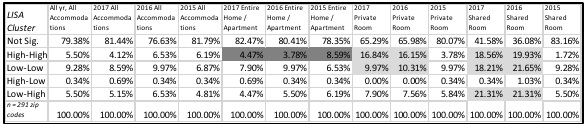
Table 2. Proportions of zip codes in LISA clusters, 2015-17, for various types of Airbnb